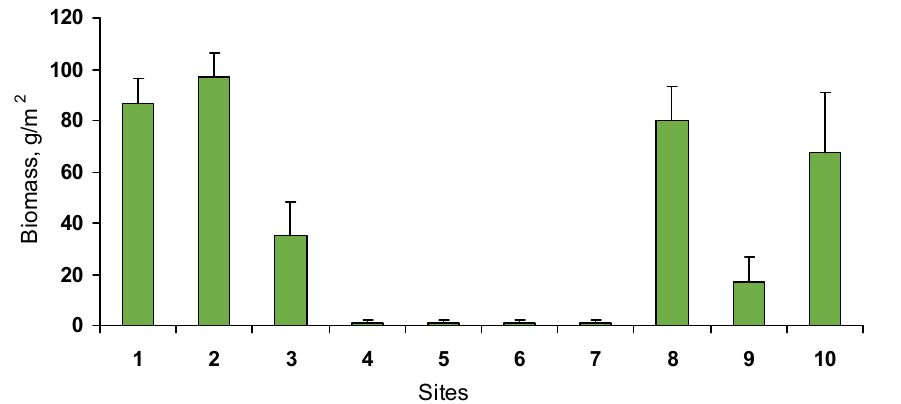
Figure 2. Mean biomass in dry weight (g/m 2 ) and standard error (+1SE, n = 3) of growing Cladophora glomerata at study sites.